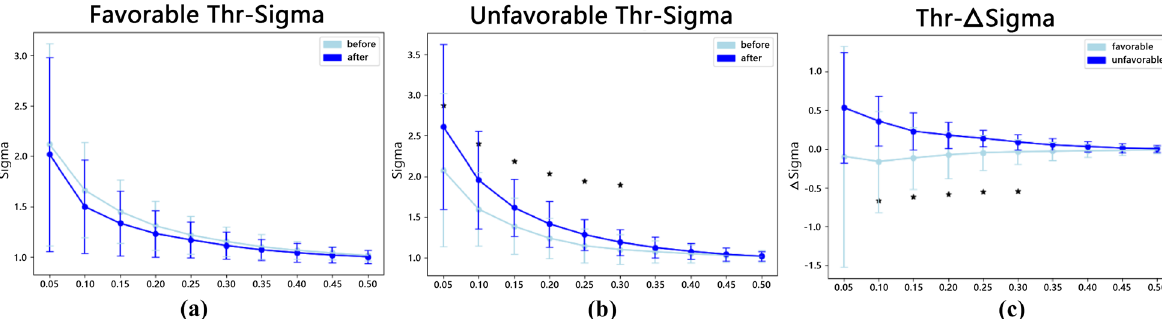
Fig. 6 Small-world results. a and b are the σ distributions of patients in the favorable and unfavorable groups, respectively. c is the ∆σ distribution